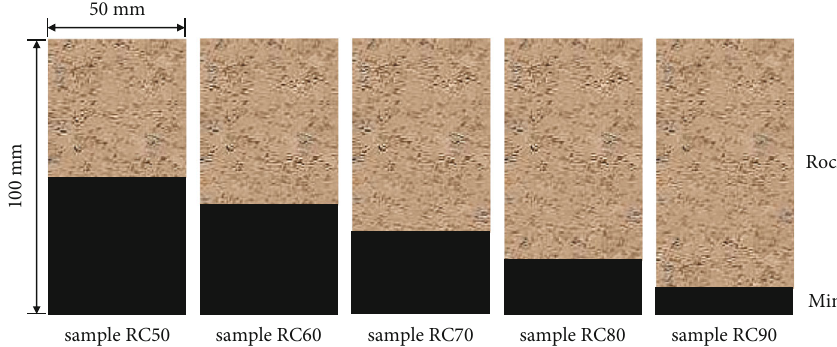
Figure 1: Schematic diagram of the design scheme of the